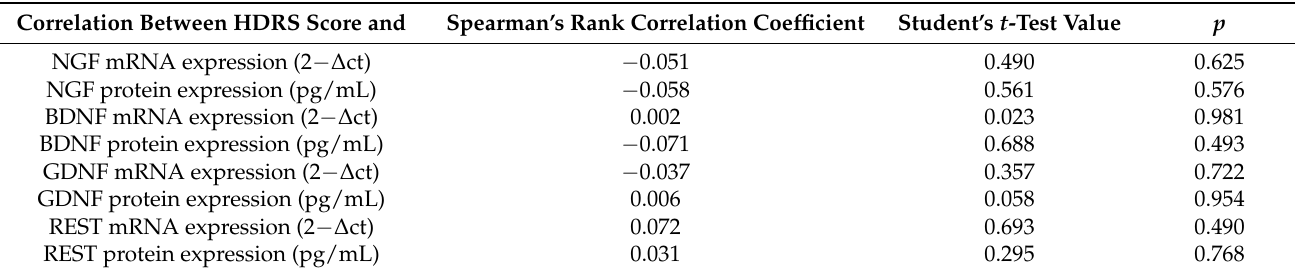
Table 3. Correlation between mRNA and protein expression for selected genes regulating the process of neurogenesis and the severity of depressive symptoms measured with HDRS score in patients from the study